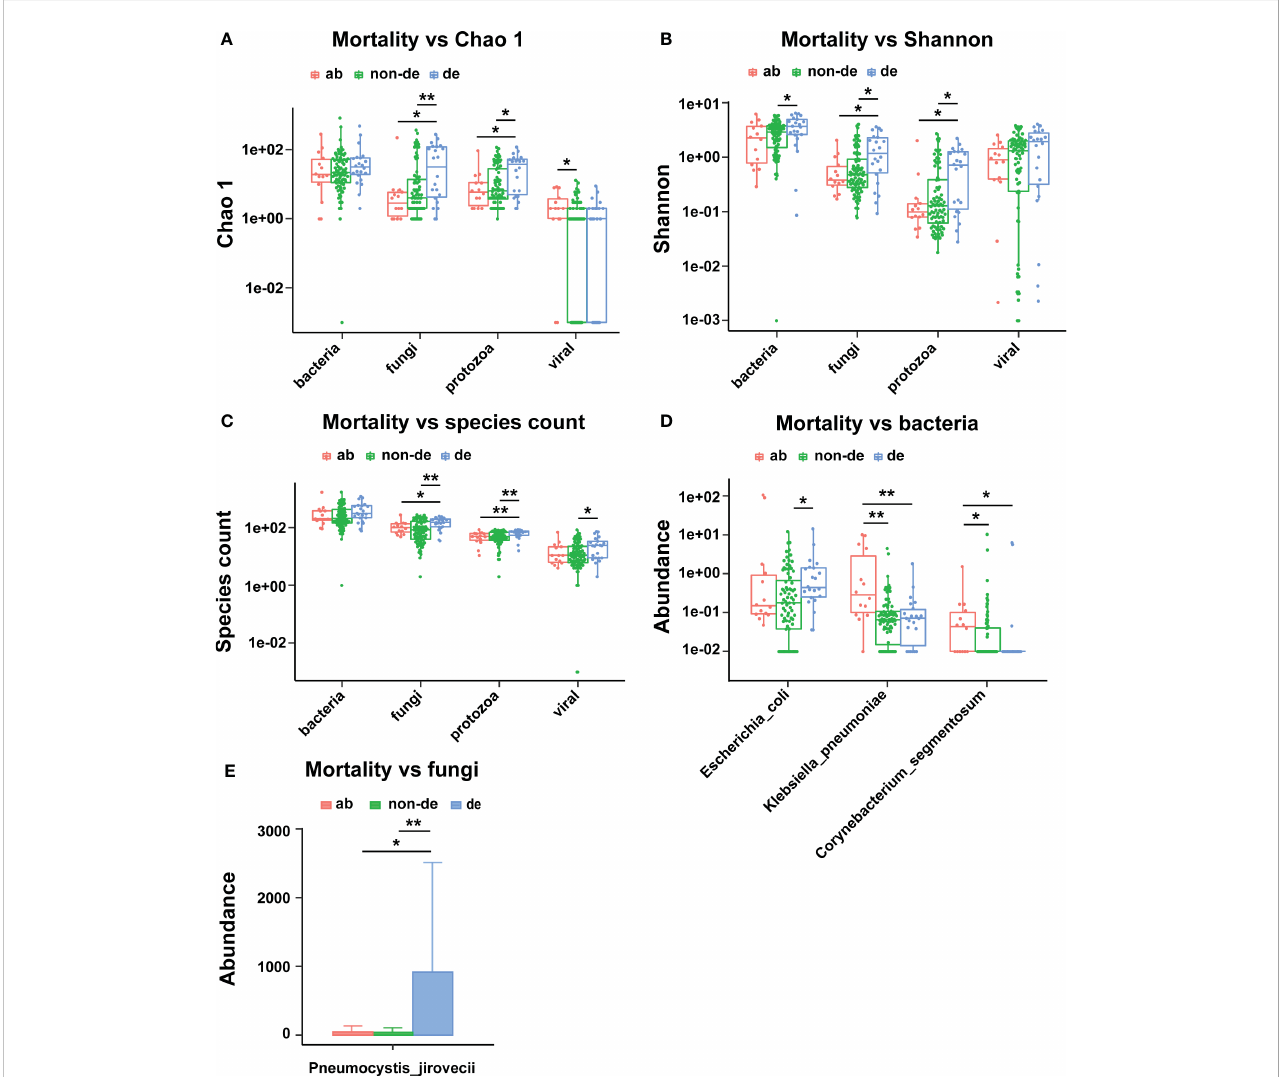
FIGURE 5 Ecological diversity and composition of pathogenic microorganisms in BALF associated with mortality. (A) Mortality associated with Chao1; (B) Mortality associated with Shannon index; (C) Mortality associated with species count; (D) Mortality associated bacteria; (E) Mortality associated with fungi. ab, abandoned; de, deceased; non-de, non deceased. * p < 0.05, ** p <